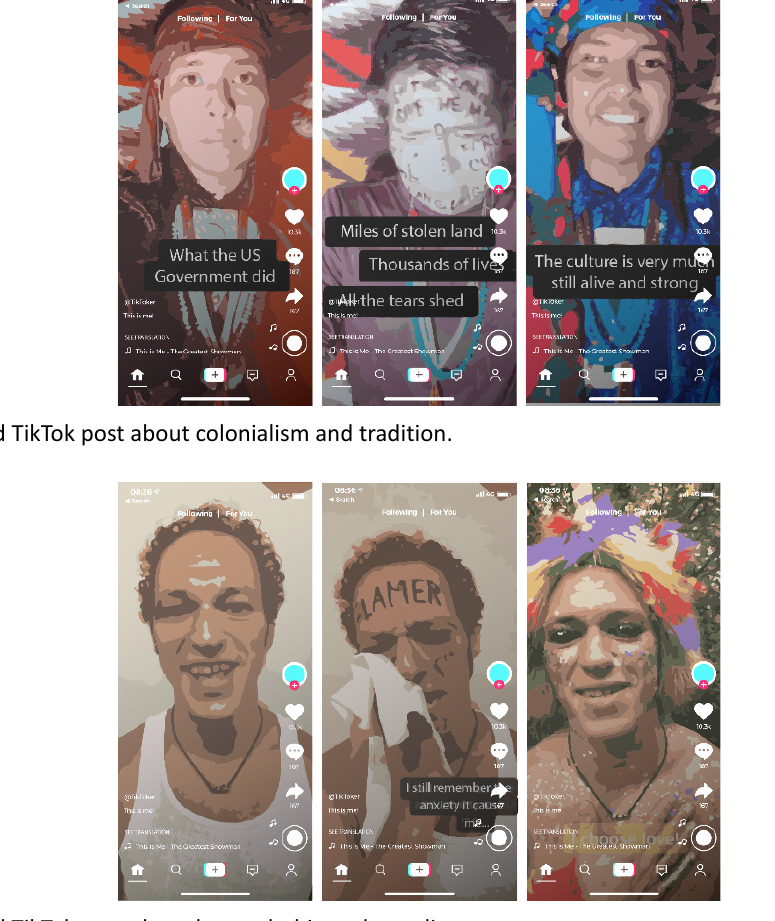
Figure 6. Illustrated TikTok post about homophobia and